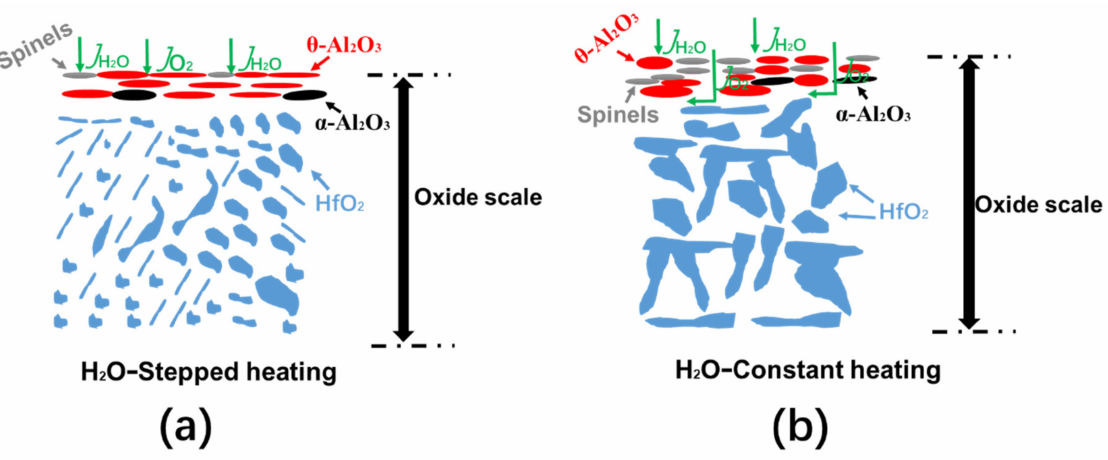
Figure 7. Schematic diagrams of the oxidation process of the NiCrAlHf bond coat alloy in a water vapor atmosphere during ( a ) stepped heating and ( b ) constant